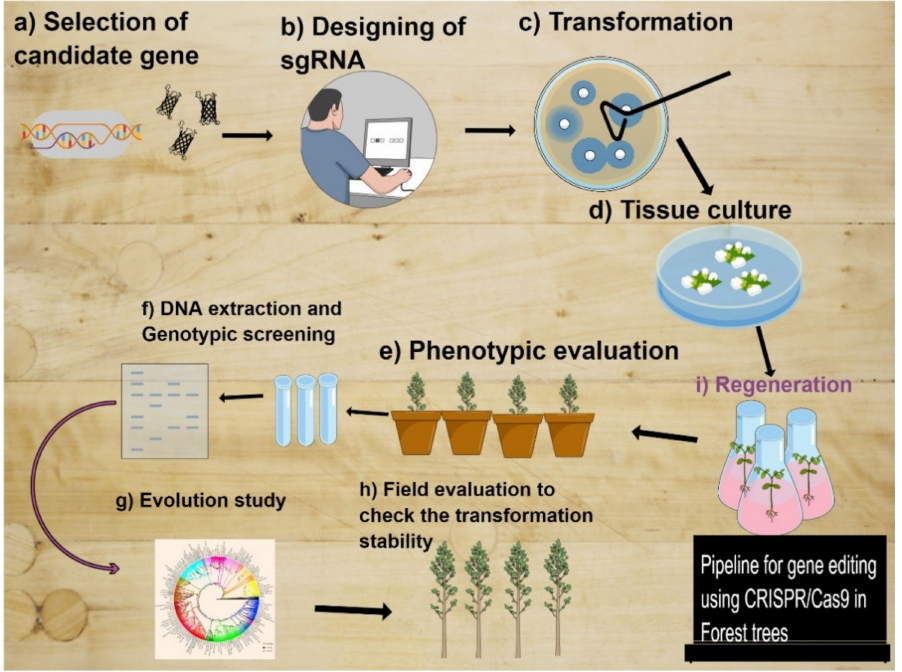
Figure 1. The pipeline of CRISPR/Cas9 to develop the transgenic plants in a forest tree. ( a ) Selection of candidate gene according to the trait under selection. ( b ) Design of the target on the gene sequence using any available online tool for sgRNA designing. ( c ) Construction of vector and transformation of cas9 vector into the explant through agrobacterium mediated transformation. ( d ) Develop the transgenic plants by tissue culture and regeneration of plant from the explant. ( e ) Regenerated plants are grown under glasshouse conditions to check the phenotypic according to the proposed objective. ( f ) Extract the DNA for genotypic analysis of plant carry mutation either homozygous or heterozygous or mutation didn’t occur. This step can be performed before phenotypic evolution. ( g ) On this step, check the evolutionary study if necessary, according to the trait under